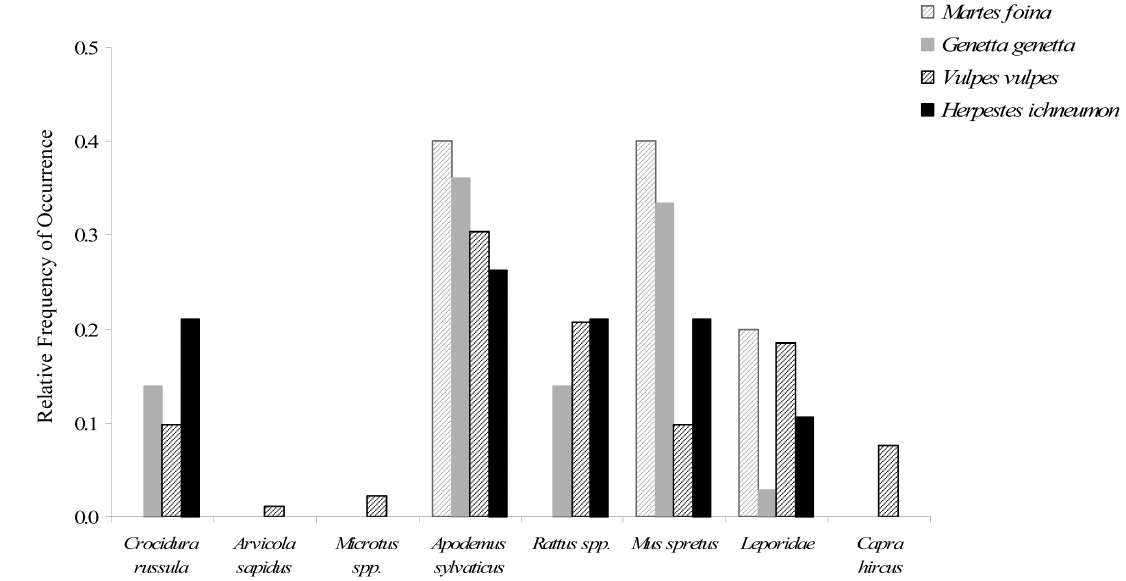
Fig. 1. Relative frequency of occurrence of mammal species consumed by four carnivores in SW Portugal (order Insectivora: family Soricidae: Crocidura russula ; order Rodentia: family Muridae: Arvicola sapidus , Microtus spp., Apodemus sylvaticus , Mus spretus, and Rattus spp.; and order Lagomorpha: family